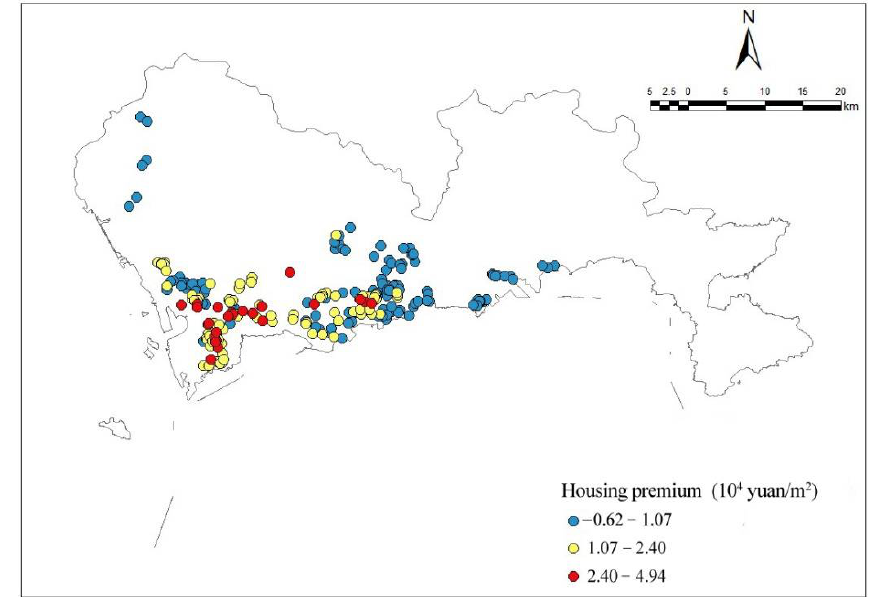
Figure 6. Spatial distribution of housing premium as a result of urban renewal.